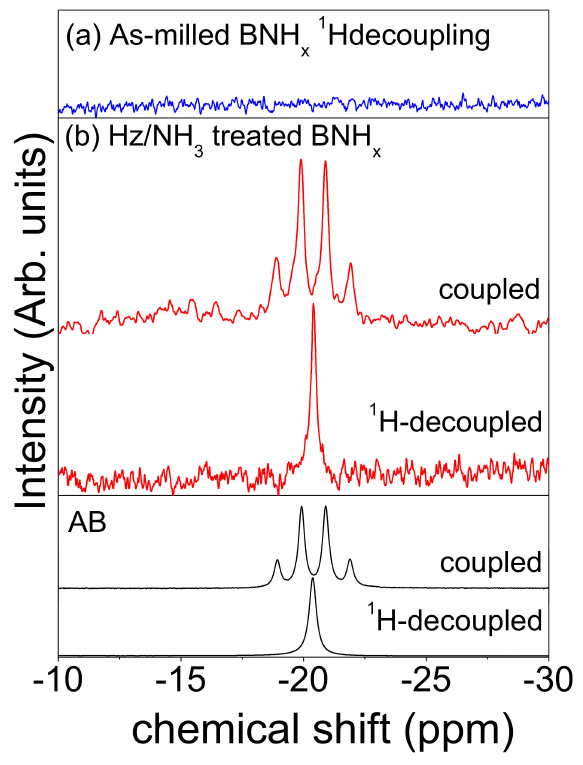
Figure 2. 11 B solution NMR spectra of ( a ) as-milled BNH x with 1 H-decoupled and ( b ) BNH x after N 2 H 4 / NH 3 treatment with 1 H-coupled and decoupled. Profiles of ammonia borane (AB) as a reference are also